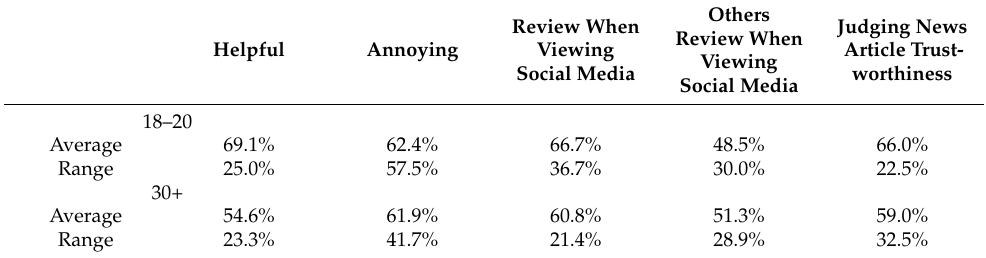
Table 19. Data characteristics—informational and warning label survey by age